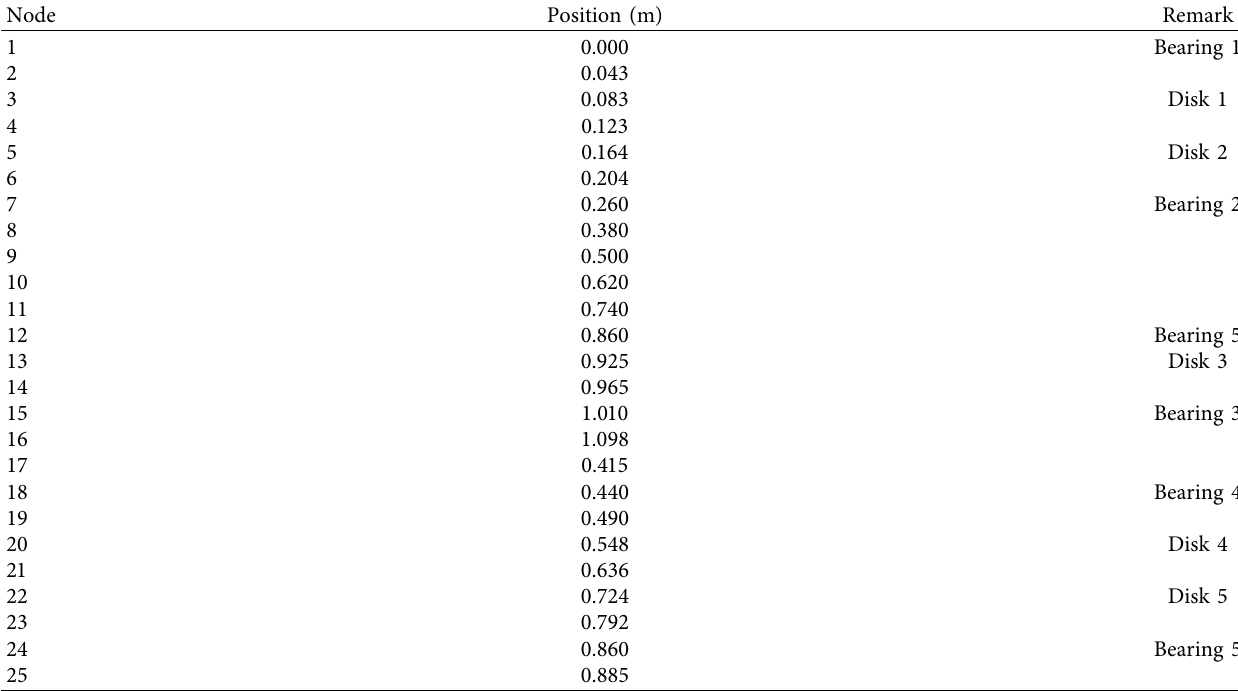
Table 1: Node location.